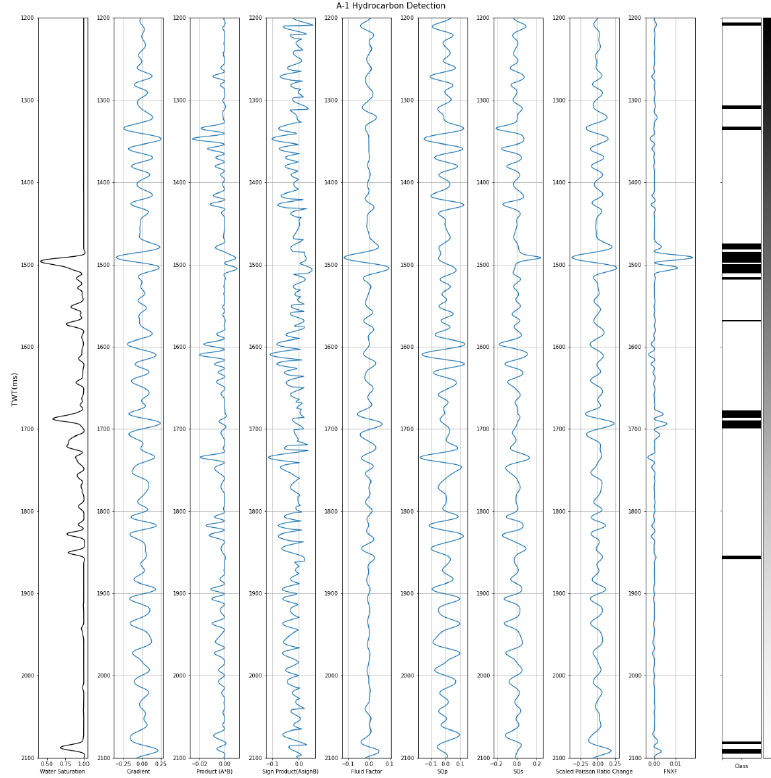
Figure 11. Hydrocarbon delineation on A − 1. Appl. Sci. 2022 , 12 , x FOR PEER REVIEW